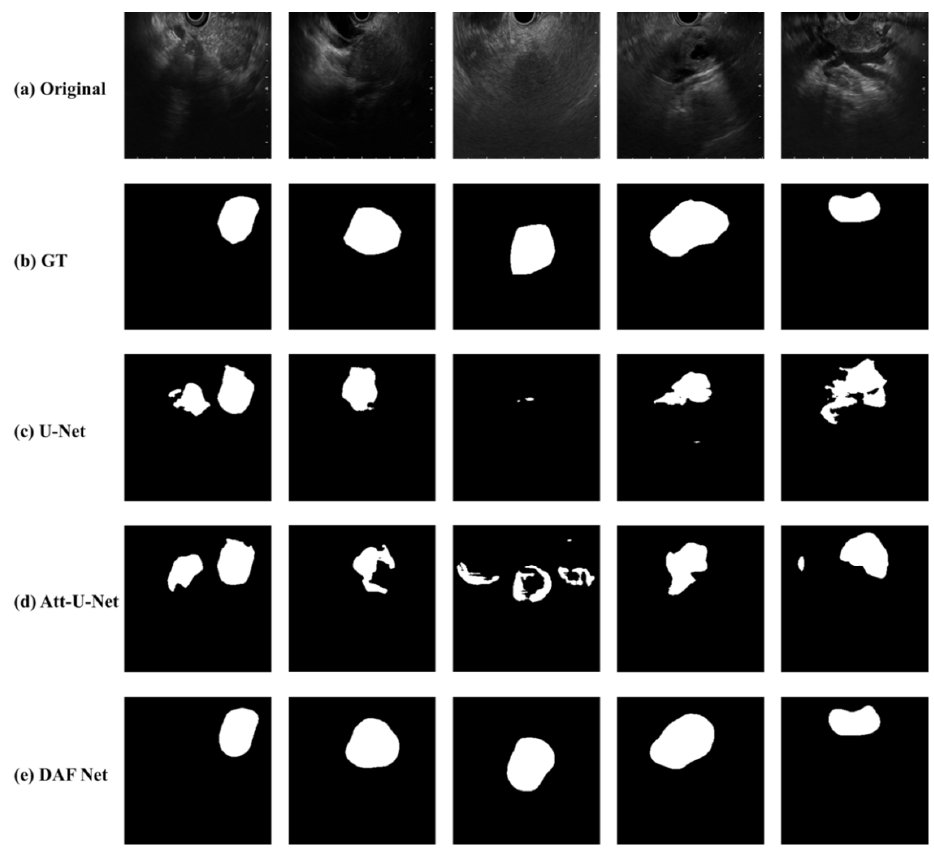
Figure 6. Examples of ( a ) original EUS images with pancreatic cancer, ( b ) GT, and segmentation results from ( c ) U ‐ Net, ( d ) Att ‐ U ‐ Net, and ( e ) DAF ‐ Net. The segmentation performance in terms of the size and position of the pancreatic cancer were compared by Kruskal–Wallis test and visualized by a box plot. The Kruskal–Wallis tests show that no significant differences ( p value = 0.98 and 0.9 for DSC and IoU, respectively) were found among the three different stages (i.e., T1, T2, and T3), and that no significant differences ( p value = 0.13 and 0.13 for DSC and IoU respectively) were found among the five different parts (i.e., body, head, neck, tail, and uncinate). However, the p value is relatively low, and the most significant difference was observed between the cancers located in the tail and uncinate where the p value was 0.01 for both the DSC and IoU. Figures 7a,b show box plots with the median (red line inside the box), upper and lower quartiles (top and bottom edges of the box), and min and max of nonoutliers (whiskers) of the DSC (Figure 7a) and IoU (Figure 7b) of DAF ‐ Net from three different cancer stages (T1–3), respectively. Figures 7c,d show the median, upper and lower quartiles, and min and max of nonoutliers of the DSC (Figure 7c) and IoU (Figure 7d) of DAF ‐ Net for five different locations of the pancreatic cancer, respectively. Similar to the result from the Kruskal–Wallis test, the box plots show that there is no significant difference in terms of the tumor stage and the position of the pancreatic cancer.